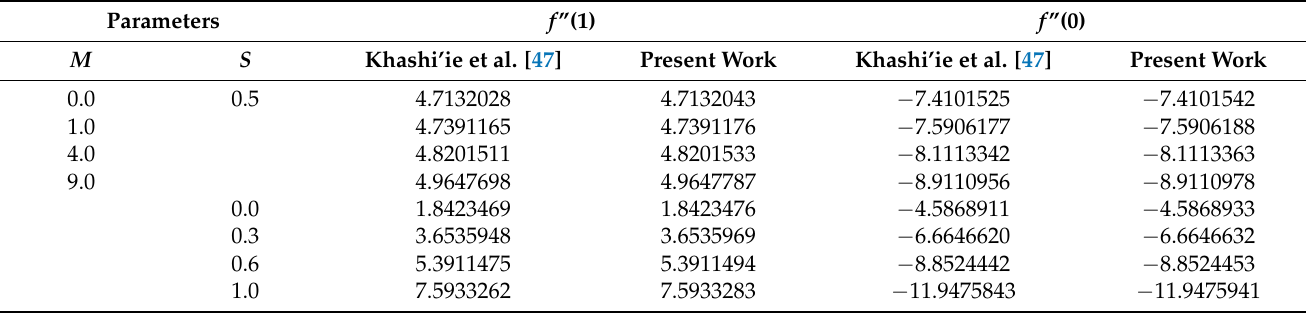
Table 3. The comparative assessment of present outcomes with the published literature for upper and lower plate skin friction ( f ”(1), f